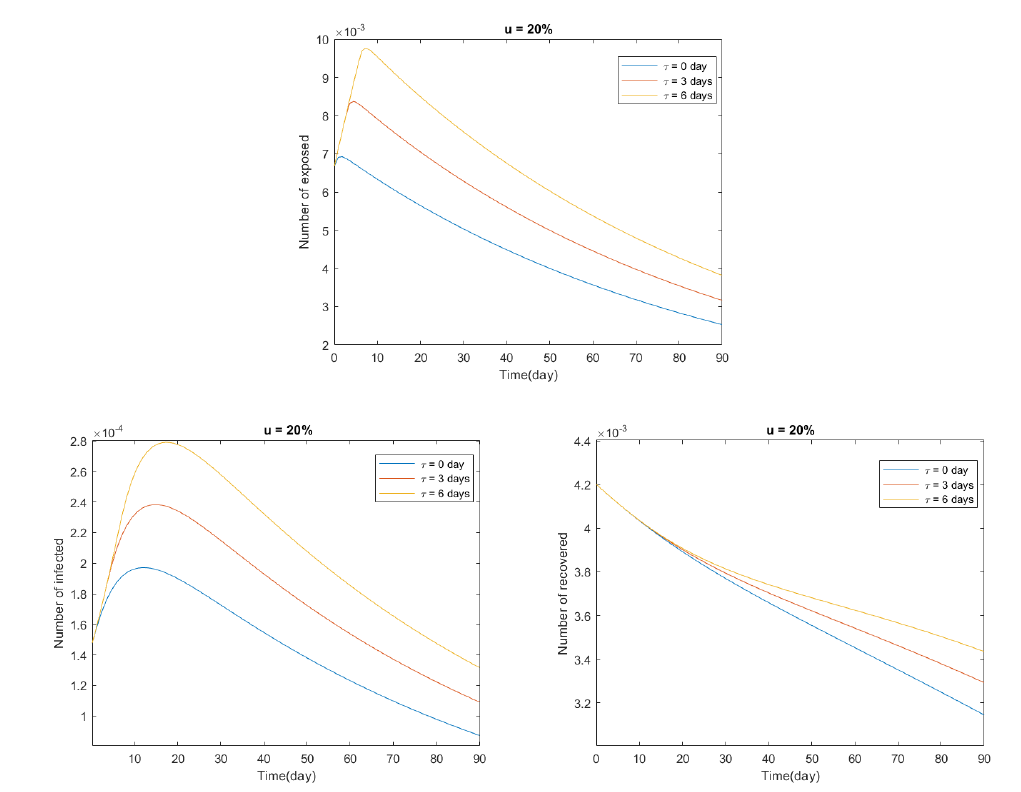
Figure 4. Predictions for Italy from the delayed model (24) with u = 20% and τ ∈ { 0,3,6 }